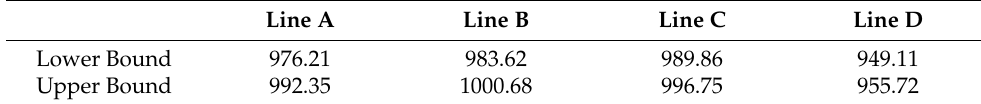
Table 2. Confidence interval for the mean cycle time (in seconds), per line. Line A Line B Line C Line D Lower Bound 976.21 983.62 989.86 949.11 Upper Bound 992.35 1000.68 996.75